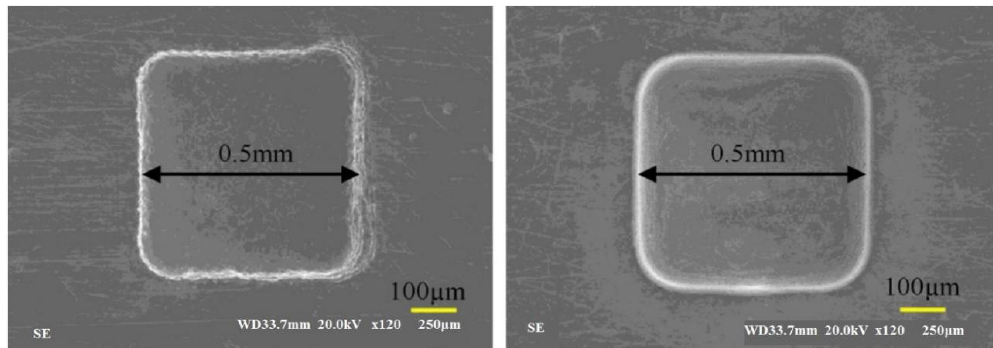
Figure 22. SR of the bottom surface [171].